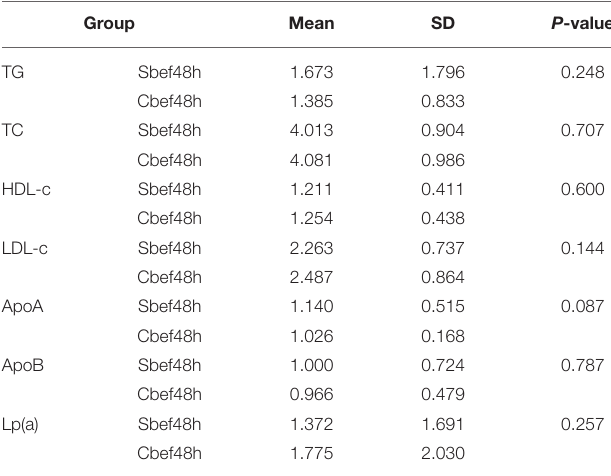
TABLE 1 | The expression of cholesterol and lipoprotein